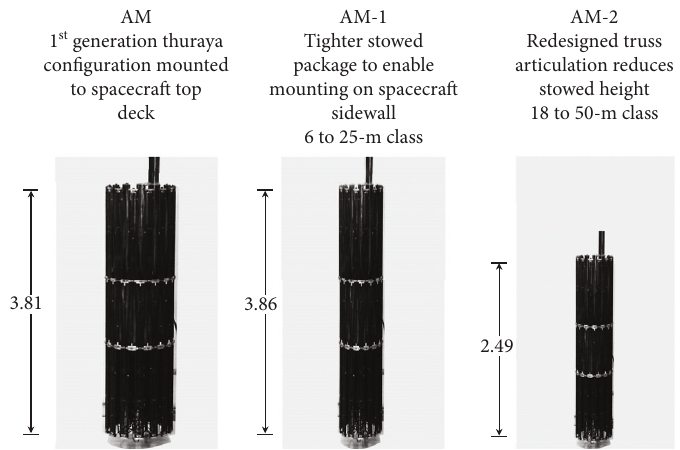
Figure 2: AstroMesh re fl ectors with 12-meter deployed